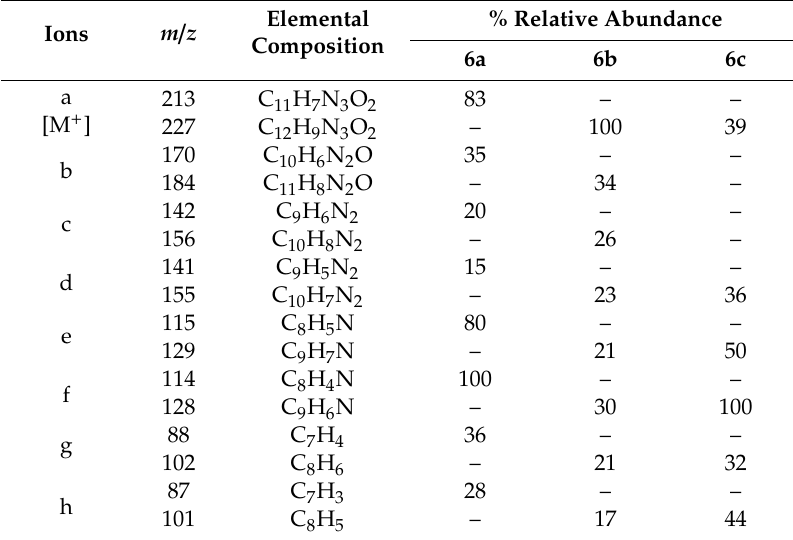
Table 1. Elemental composition and relative abundance of the ions in the spectra of compounds 6a – c according to the mass spectral